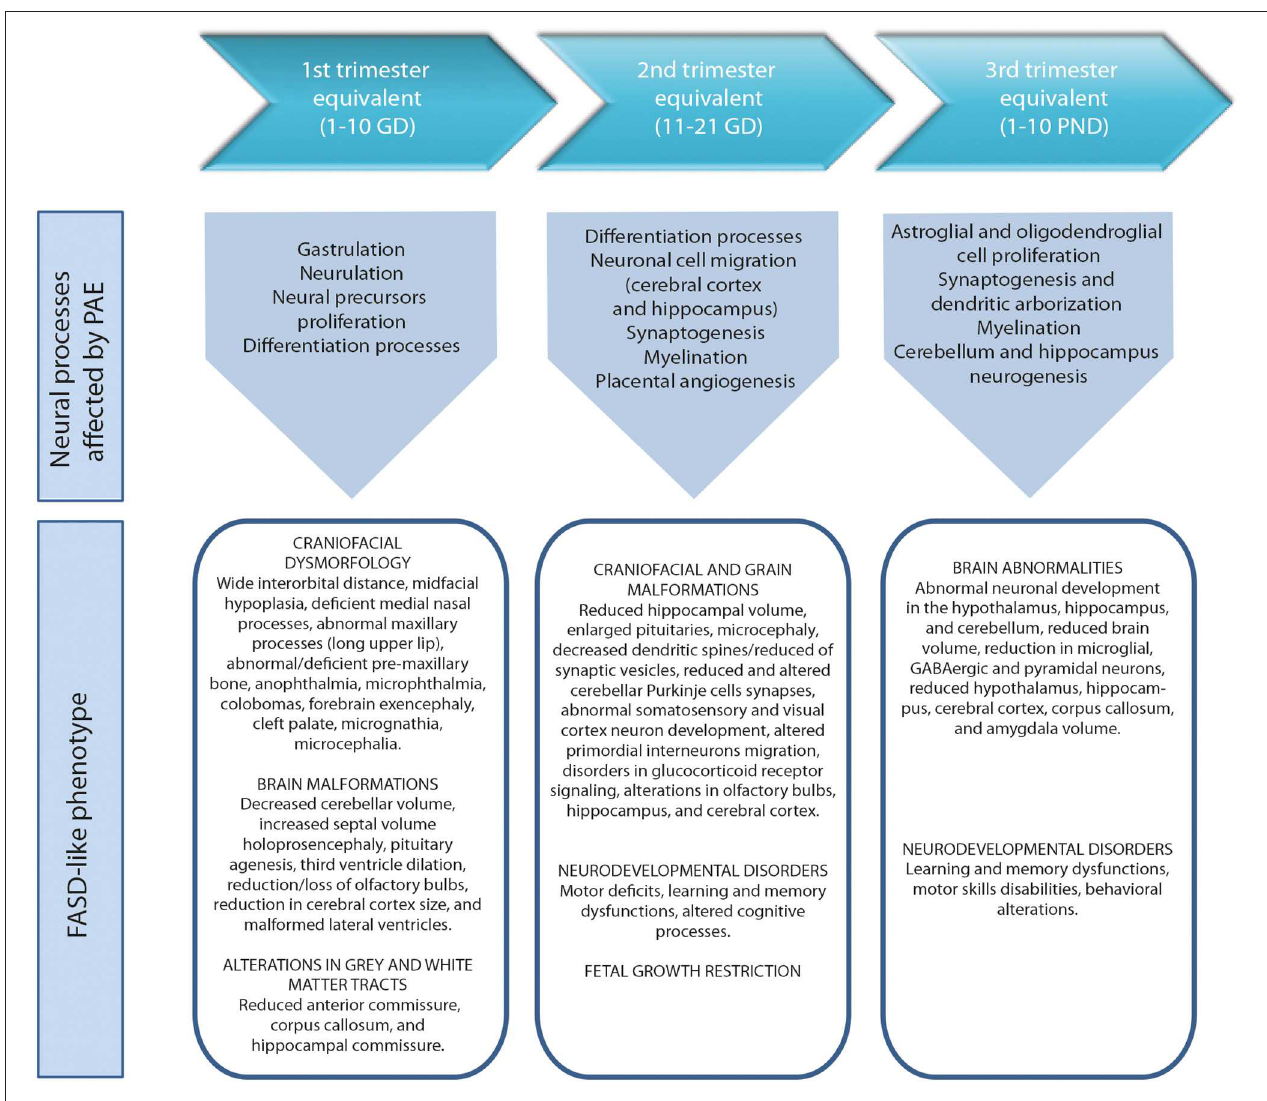
FIGURE 2 | Harmful effects of prenatal alcohol exposure in mice according to human trimesters equivalents (59). First trimester equivalent: cranial dysmorphologies (60, 61), brain malformations (61, 62) and altered gray and white matter tracts (63). Second trimester equivalent: craniofacial and brain malformations (62, 64, 65), neurodevelopmental disorders (66, 67) and fetal growth restriction (68, 69). Third trimester equivalent: brain abnormalities (70–72), neurodevelopmental disorders (71, 73). GD, gestational day. PND, postnatal